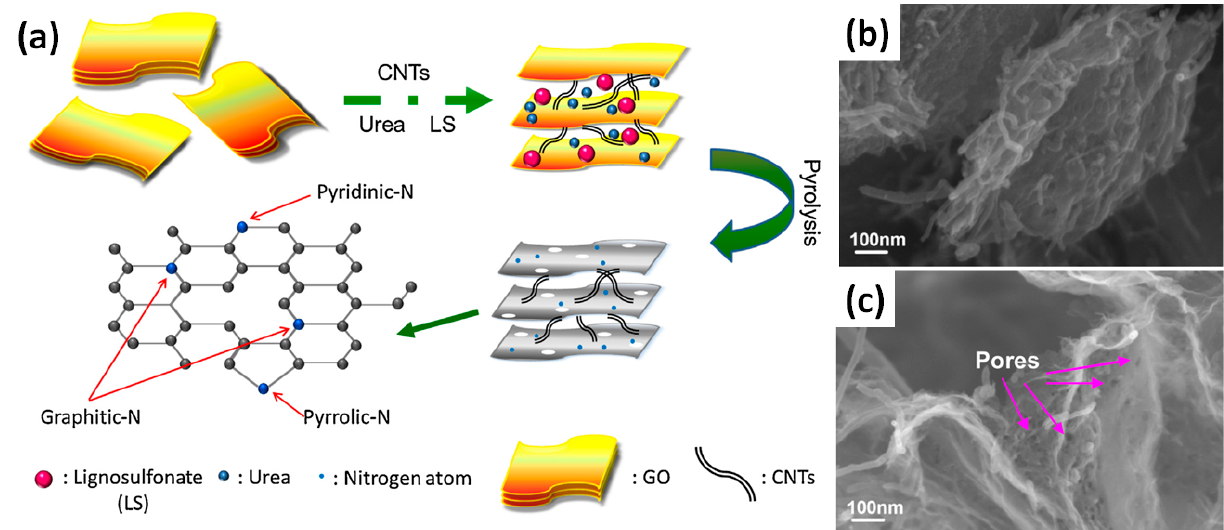
Figure 12. Schematic representation of preparation procedure of porous N-doped rGO-CNT (PNGC) composite ( a ). SEM images of lignosulfonate (LS) modified rGO-CNT ( b ) and of that after the addition of urea and heat treatment at 800 °C ( c ) (Reproduced with permission of [32]. Copyright Elsevier, 2015).